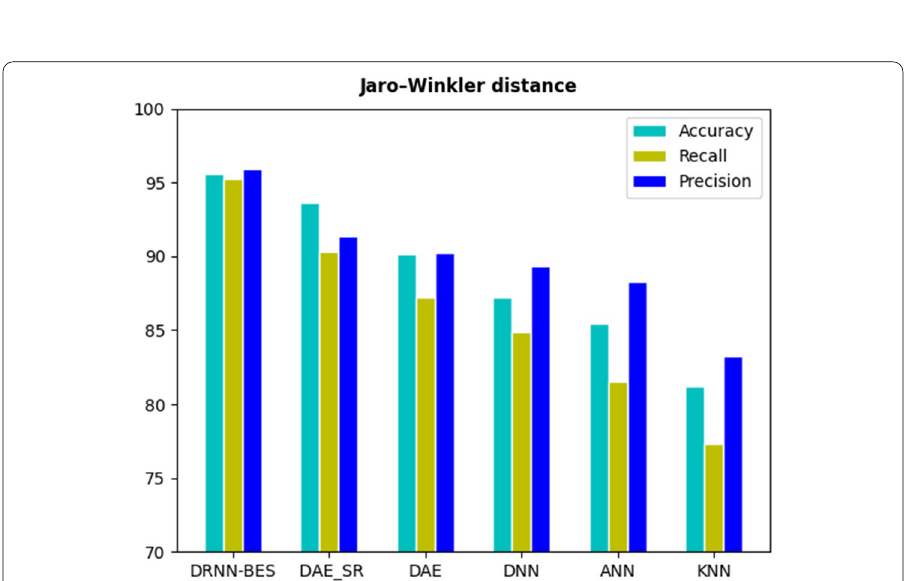
Fig. 7 Performance analysis based on Jaro–Winkler